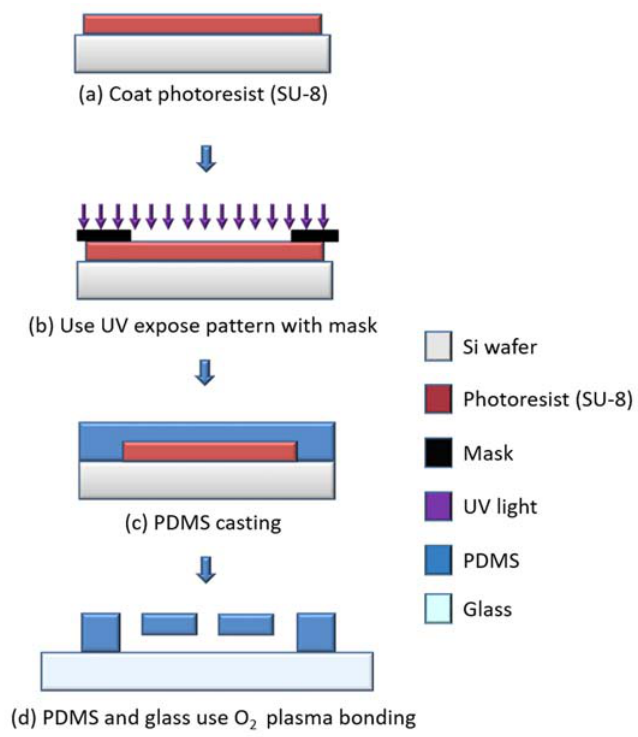
Figure 4. A schematic diagram of the microfluidic device fabrication process.